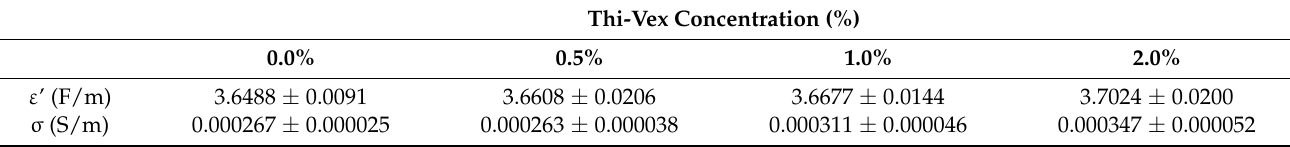
Table 2. Dielectric properties of the condensation-cured silicone relative to the concentrations of Thi-vex.